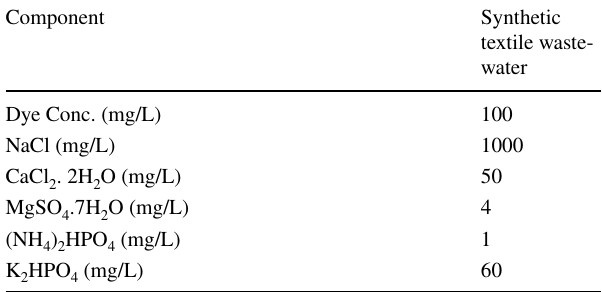
Table 1 Synthetic textile wastewater used in this study Component Synthetic